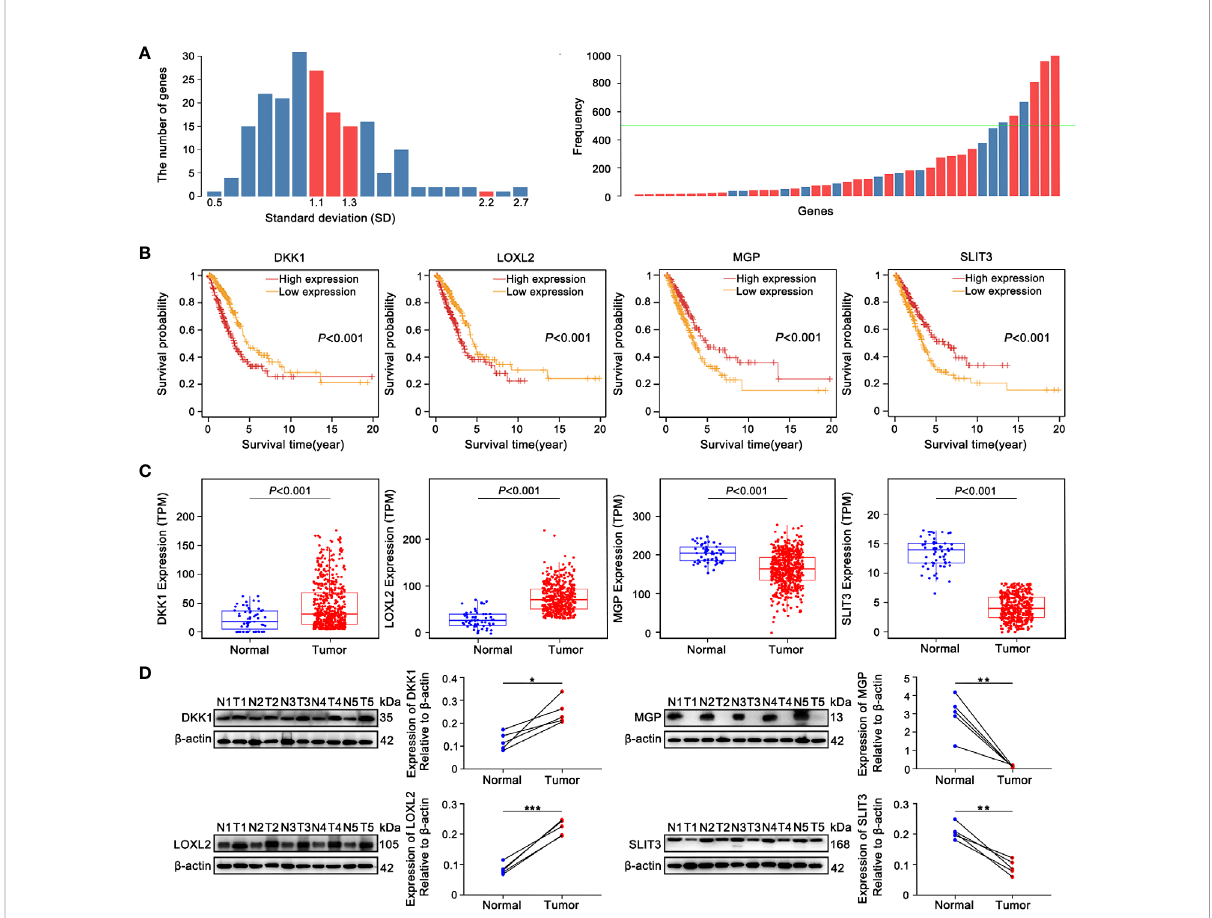
FIGURE 2 The identi fi cation 4 prognostic EMT-related genes comprising the E-signature. (A) The standard deviation distribution of all mRNAs. In the left panel, location corresponding to the red columns were standard deviation (SD) of genes with frequency greater than 500, where SD was used as the abscissa and the vertical axis represented the number of genes. The right panel showed that the gene frequency distribution chart obtained by LASSO analysis. The green baseline meant that frequency was equal to 500, the part exceeded the green line was genes with frequency greater than 500. (B) KM curves showed the overall survival (OS) of patients grouped according to expression patterns of 4 prognostic EMT-related genes comprising the E-signature in TCGA-LUAD datasets. (C) Differential expression analysis of DKK1, LOXL2, MGP and SLIT3 originated from TCGA-LUAD dataset. (D) The expression of 4 genes in fresh LUAD tumor samples (T) and adjacent normal-frozen tissues (N) detected by Western blot (* P < 0.05, ** P < 0.01, *** P <